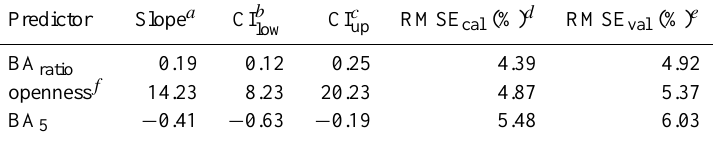
Predictor Slope a CI b